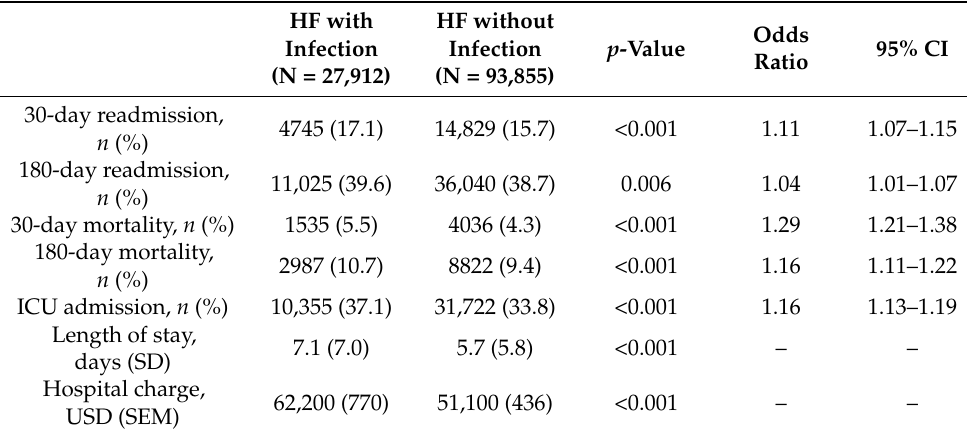
Table 3. Inverse probability of treatment weighted primary and secondary outcomes and multivari- able